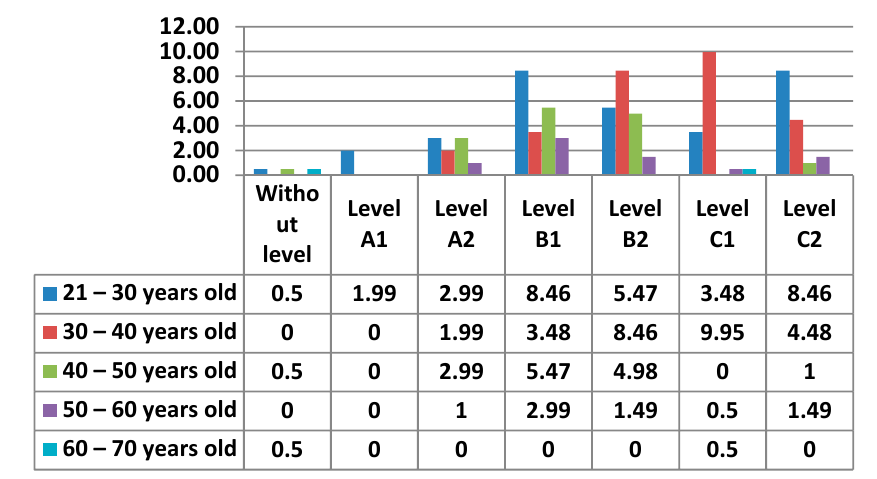
Figure 12. Level of digital competence in women by age in area 1.